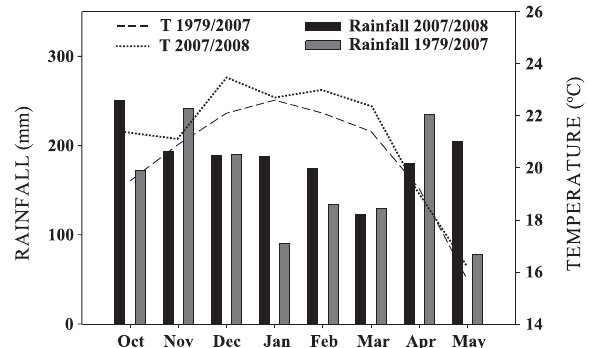
Figure 1. Historical and observed rainfall in the experimental period (Instituto Agronômico do Paraná, IAPAR, Pato Branco, PR,